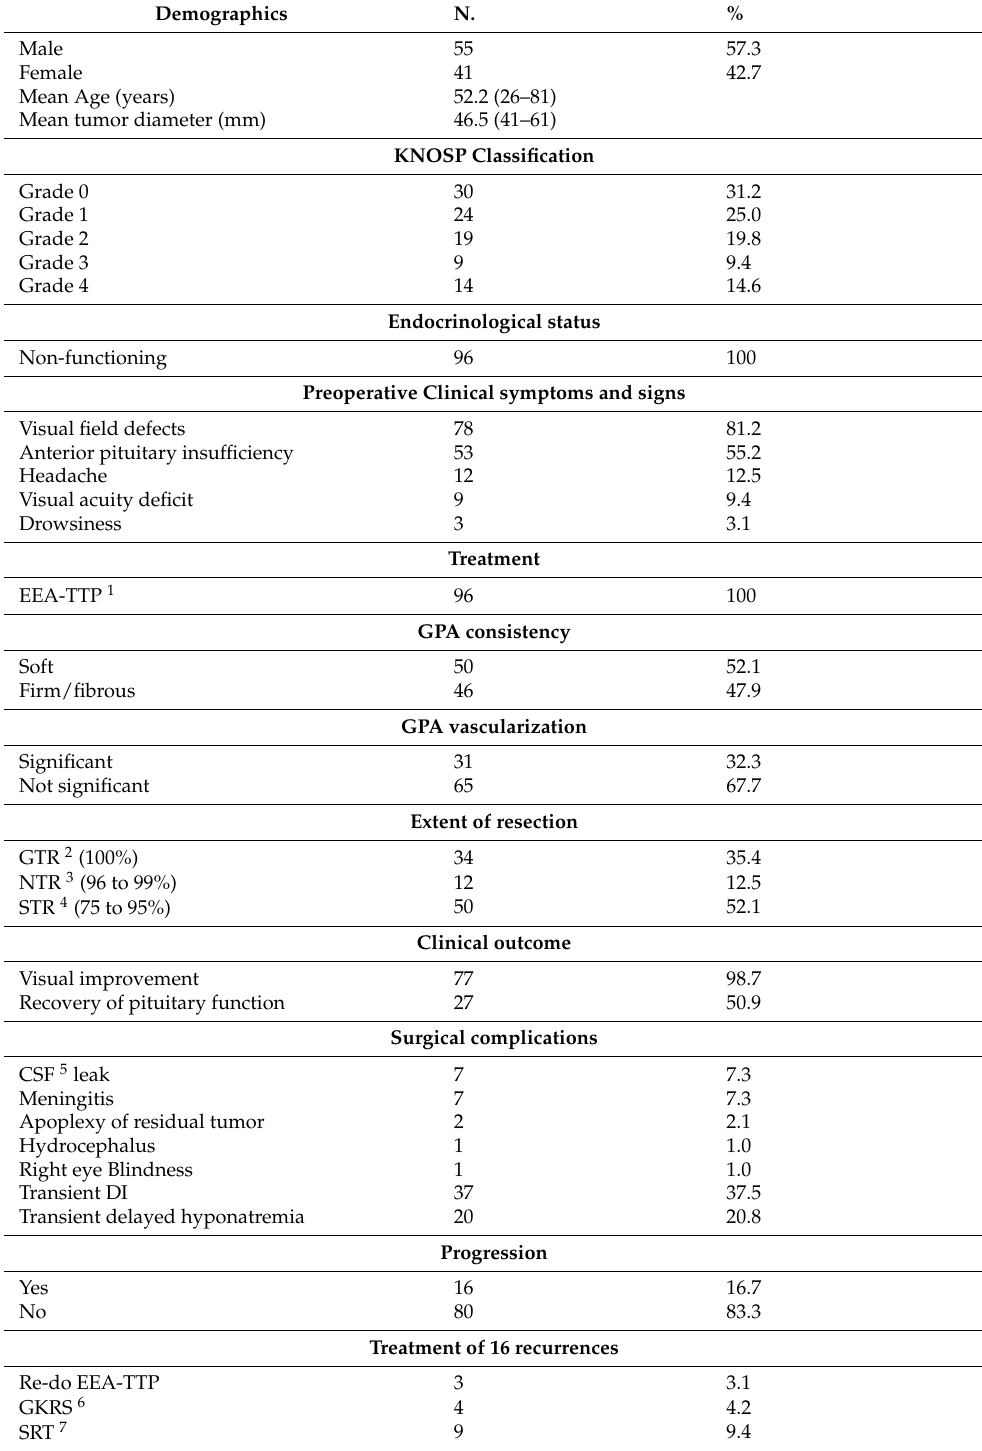
Table 1. Characteristics of a series of 96 giant pituitary